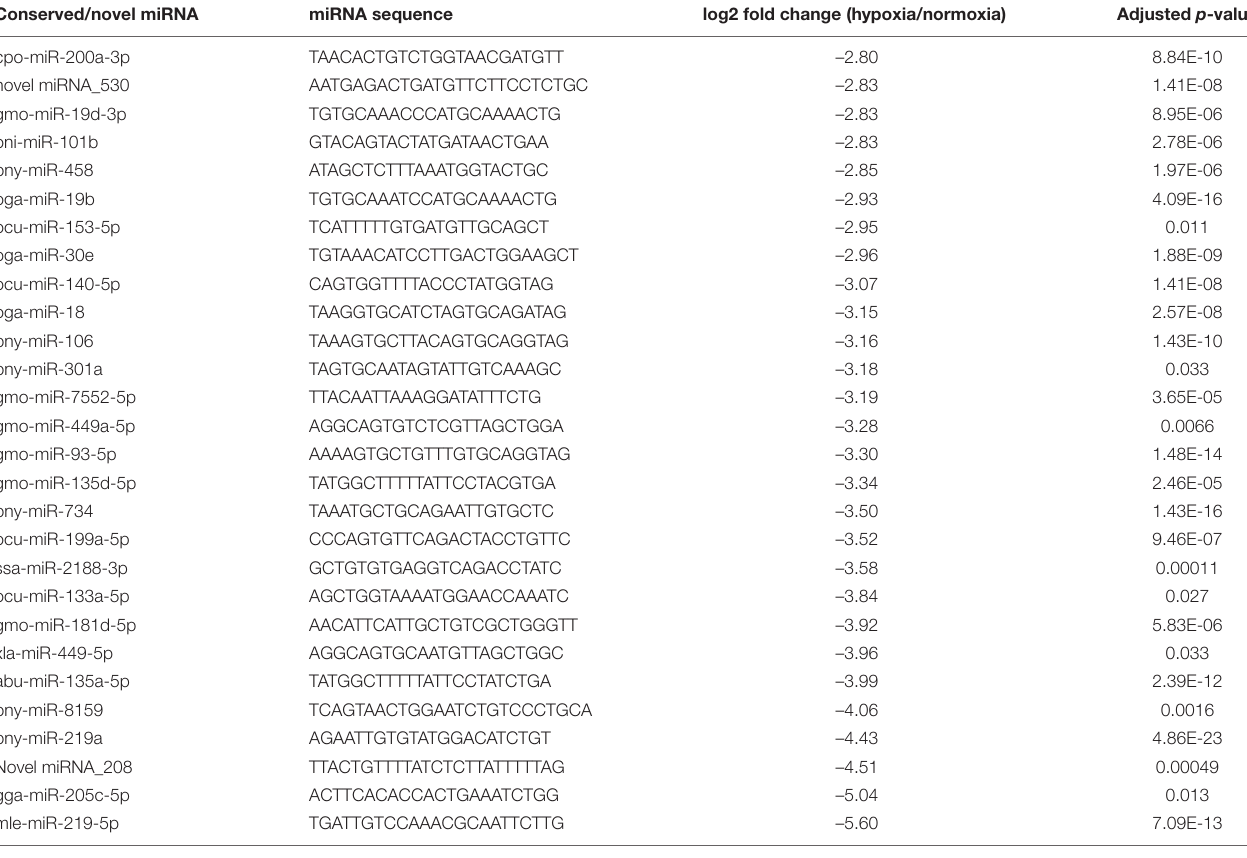
TABLE 3 | Statistics for transcriptome